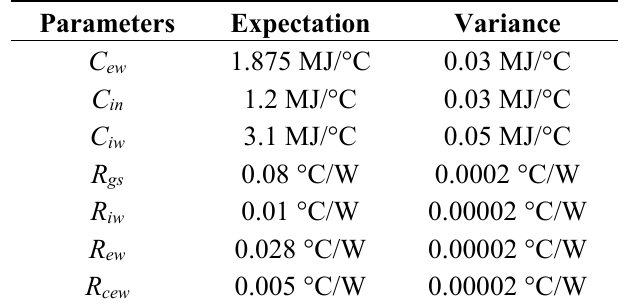
Table A1. Thermal parameters of air-conditioned indoor space.